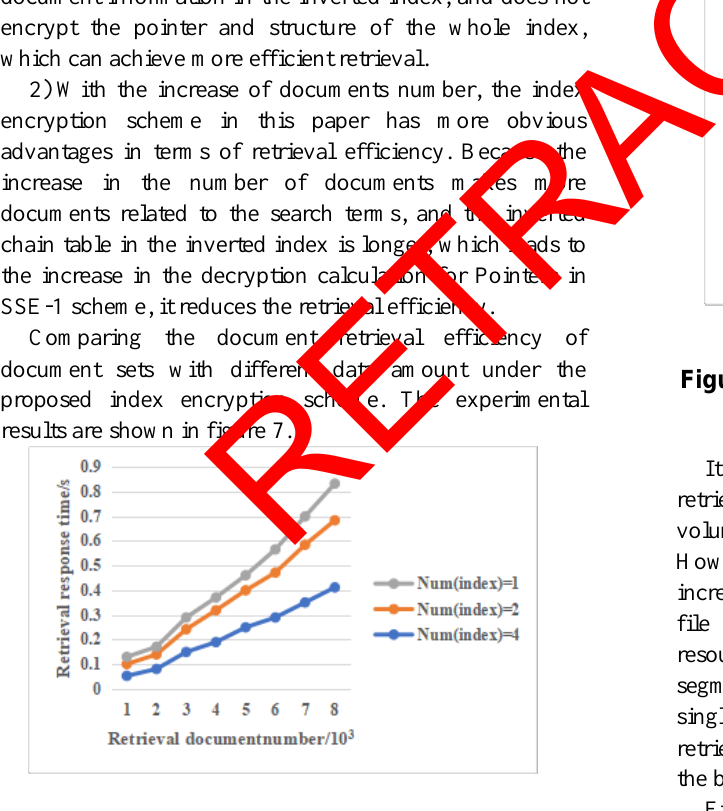
Figure 7. Comparison of single keyword retrieval efficiency.